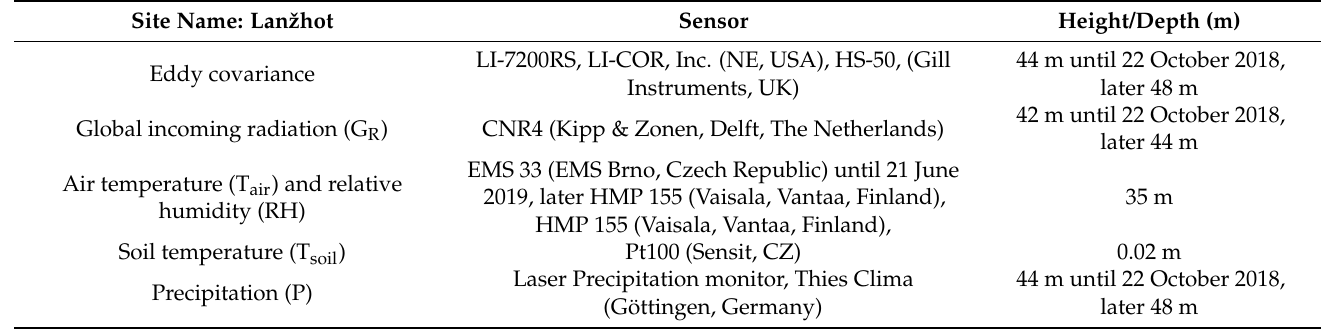
Table 1. Overview over the used instrumentation in the course of this